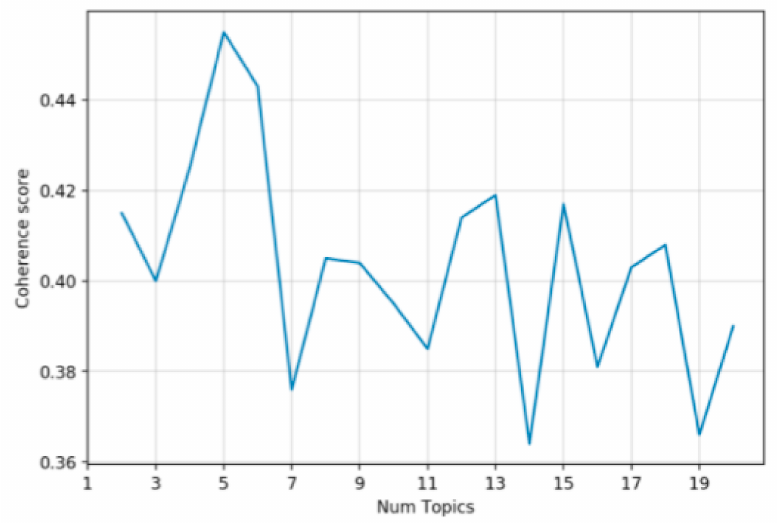
Figure 4. Topic number and coherence score from August 2019 to December